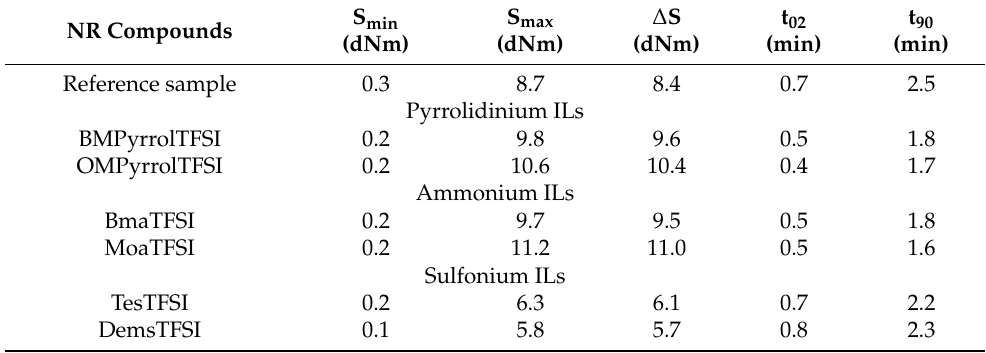
Table 4. Cure characteristics at 160 ◦ C for NR compounds containing ILs with TFSI anion (S min , min- imum torque; S max , maximum torque; ∆ S, torque increase; t 02 , scorch time; t 90 , optimal